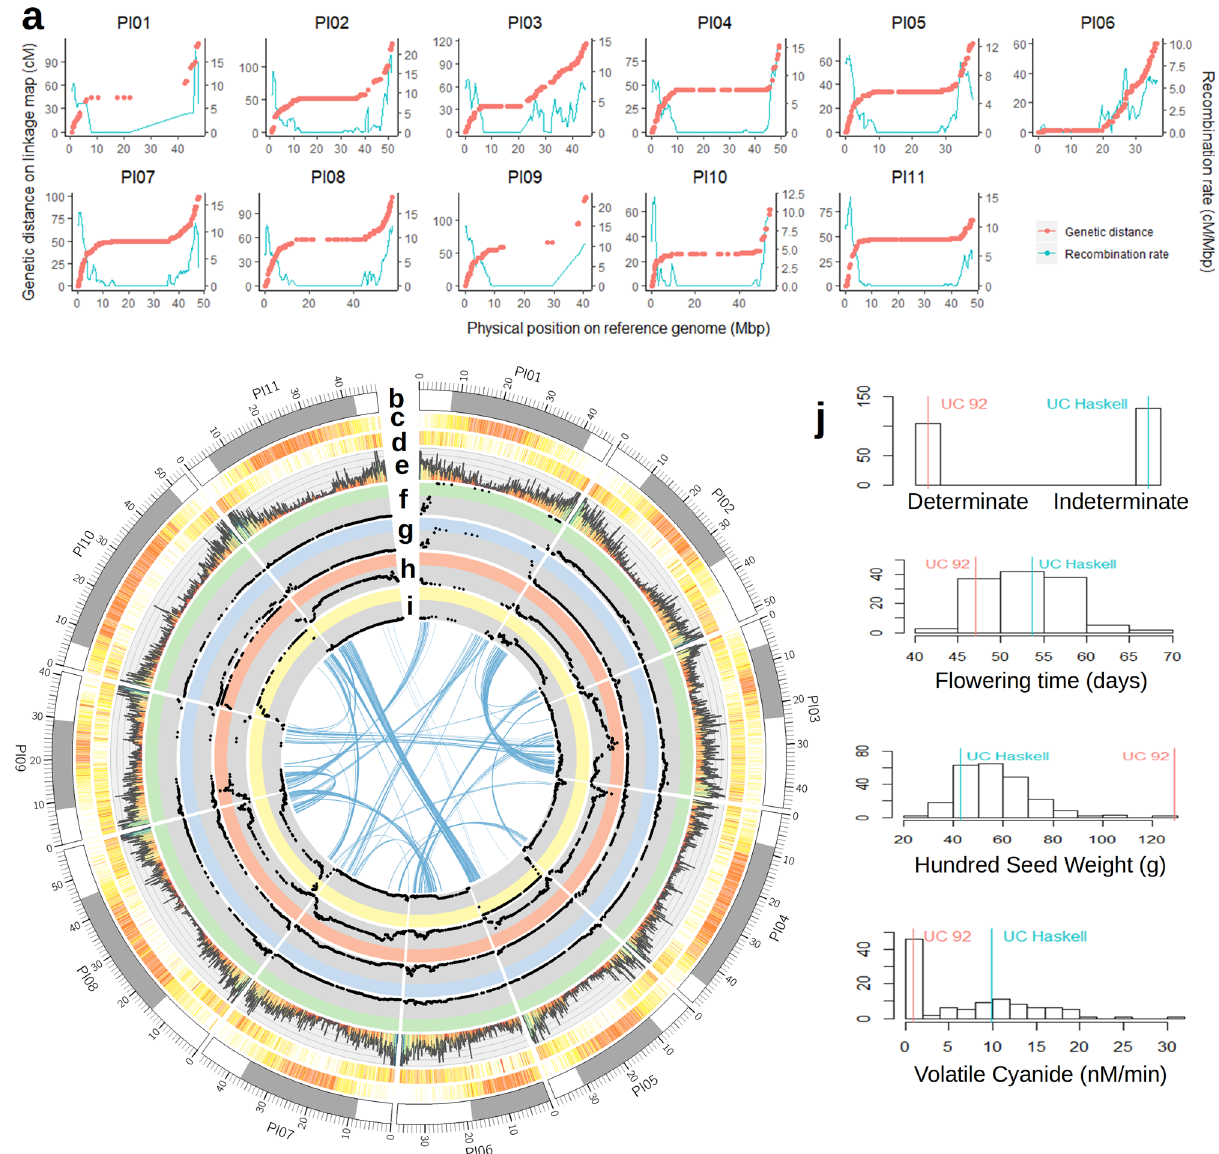
Fig. 1 Chromosome-level genome assembly for Lima bean. a Genetic distance (cM) and recombination rate (cM/Mbp) by physical position (Mbp) on the Lima bean reference genome for the UC 92 – UC Haskell RIL population. Chromosomes are labeled as Pl01-Pl11. b Chromosome lengths and pericentromeric regions. c Density of repetitive elements. d Density of gene models. e Density of SNPs. f – i . LOD scores of QTL for four different traits screened in the RIL population. Colored zones represent LOD scores greater than 3 for determinacy (green), fl owering time (blue), hundred seed weight (red), and volatile cyanide (yellow). j Phenotypic distribution of traits in the RIL population with parental phenotypes represented by vertical lines. Source data are provided as a Source Data fi